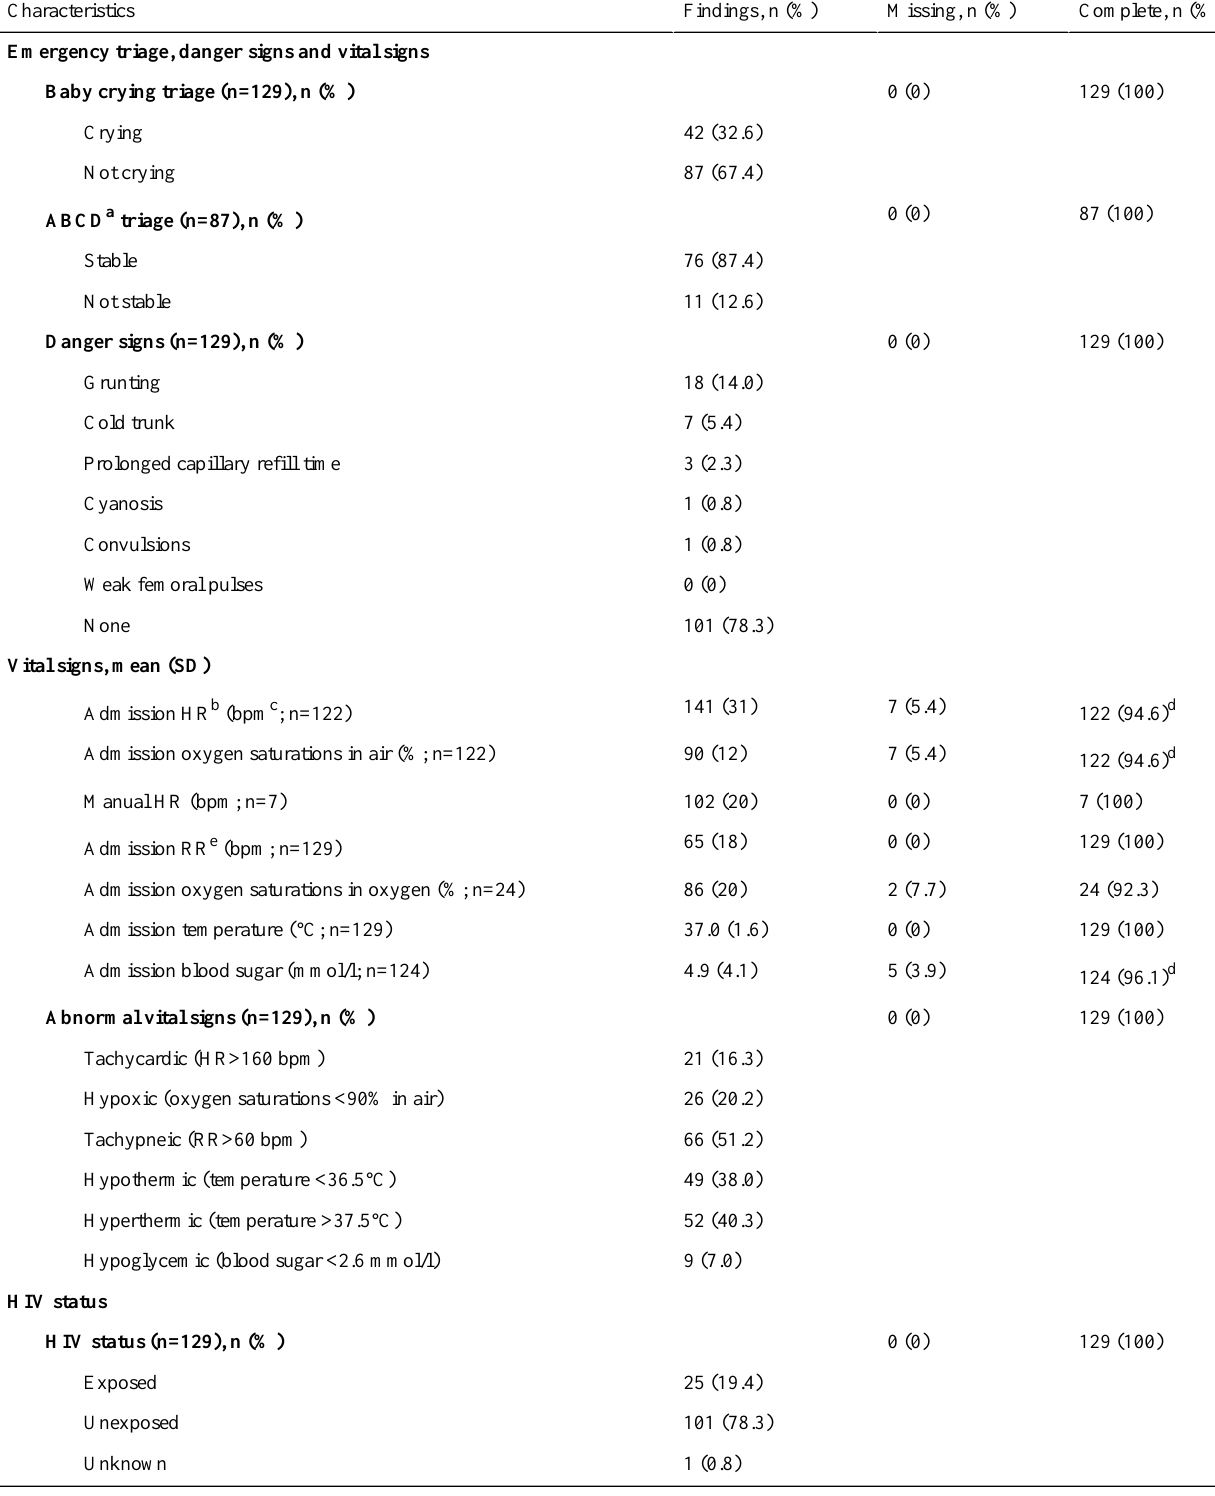
Table 3. Findings at emergency triage and HIV status of